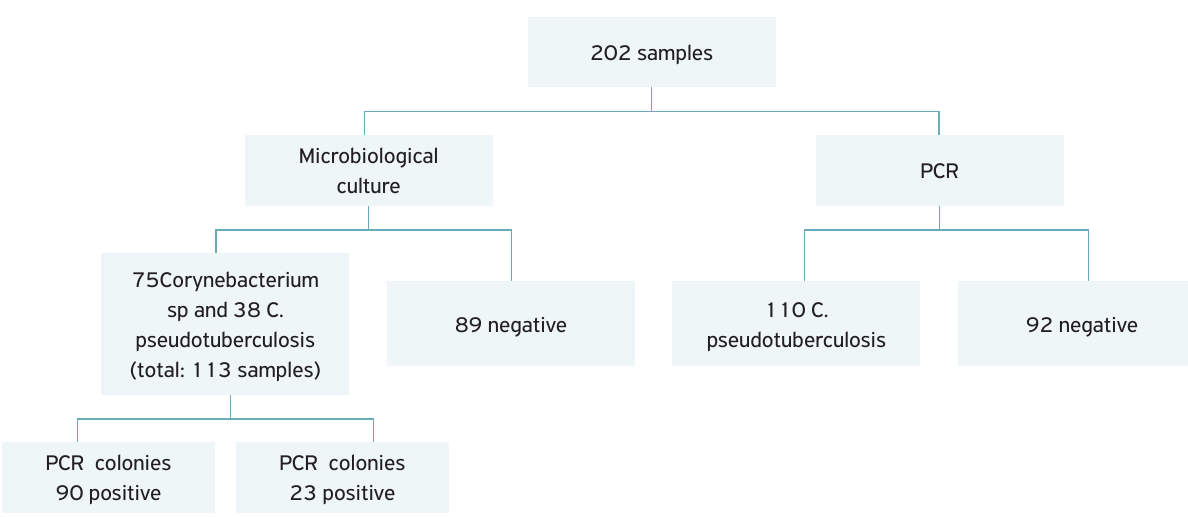
Figure 2. Distribution of results obtained in microbiology assays and multiplex-PCR made using sheep tissue